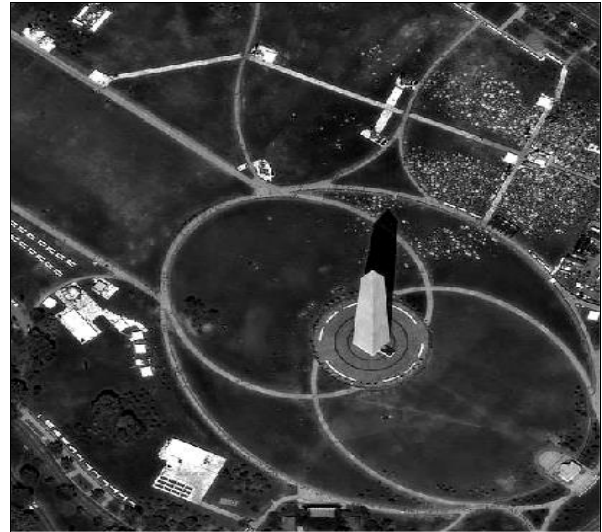
Figure 6. Image after connected component analysis